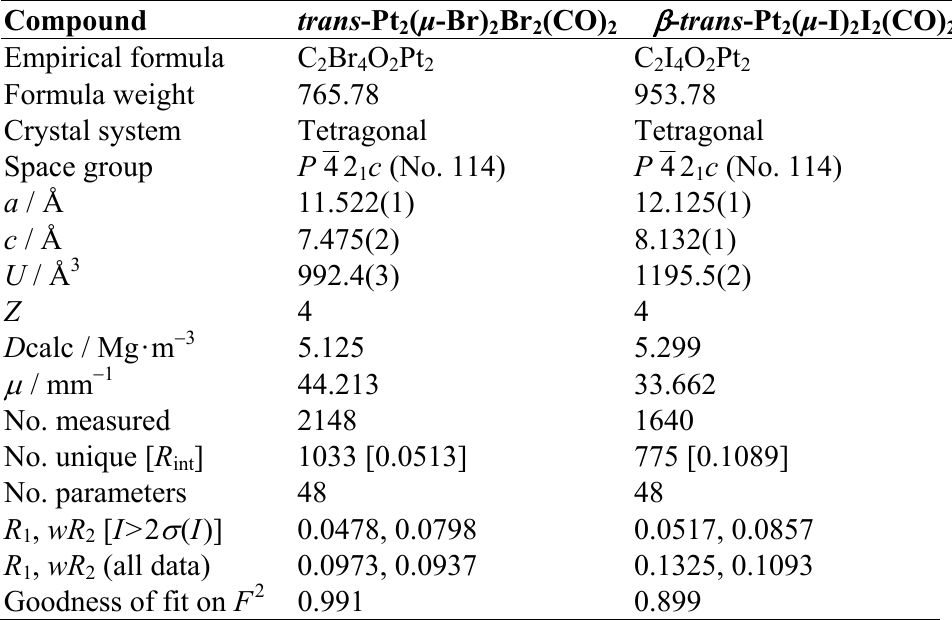
Table 2. Crystal data and structure